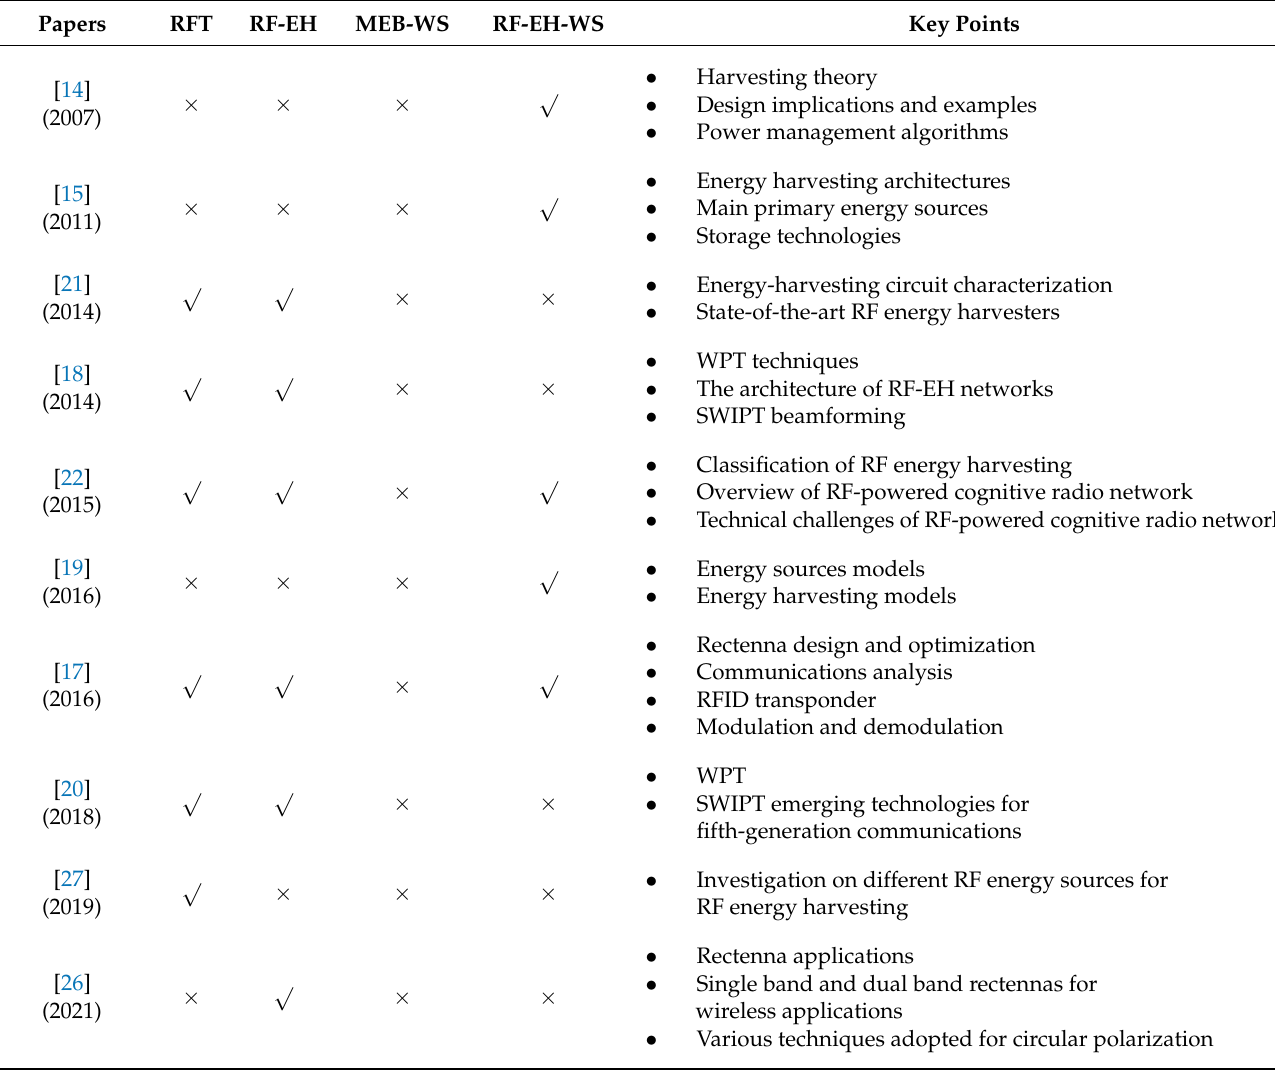
Table 1. A summary of the state-of-the-art surveys on RF-EH-WS.